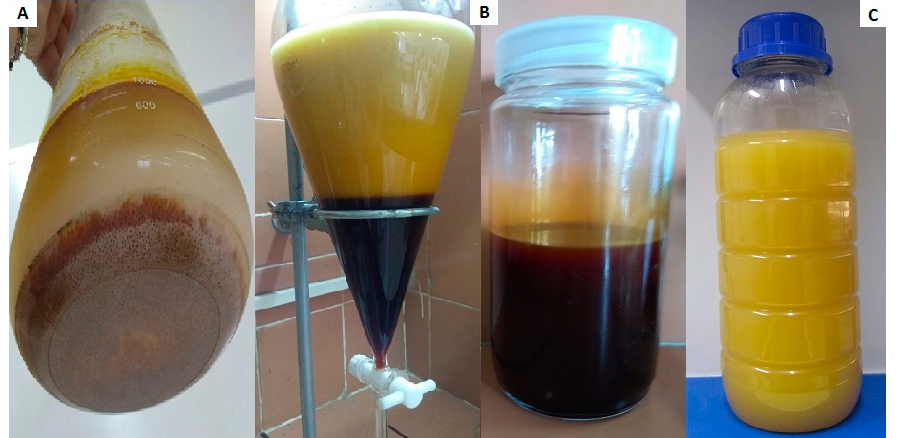
Figure 2. Illustration of the process for obtaining the biosurfactant from Starmerella bombicola ATCC 22214: ( A ) culture medium containing the biosurfactant produced and isolated in a separating funnel; ( B ) isolated biosurfactant, and ( C ) commercial biosurfactant formulation.